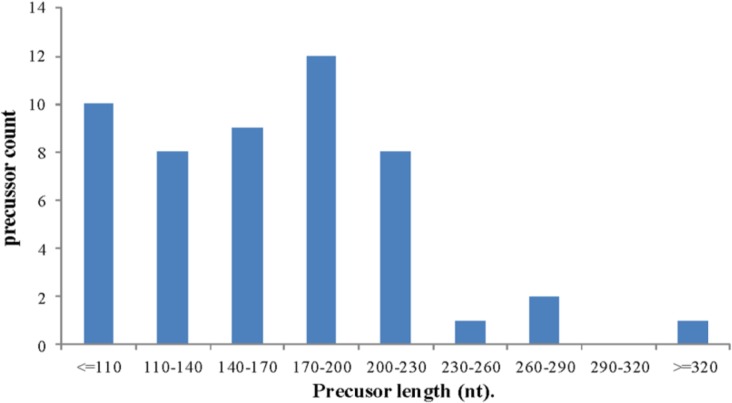
Length distribution of cucumber pre-miRNAs identified in the current study.